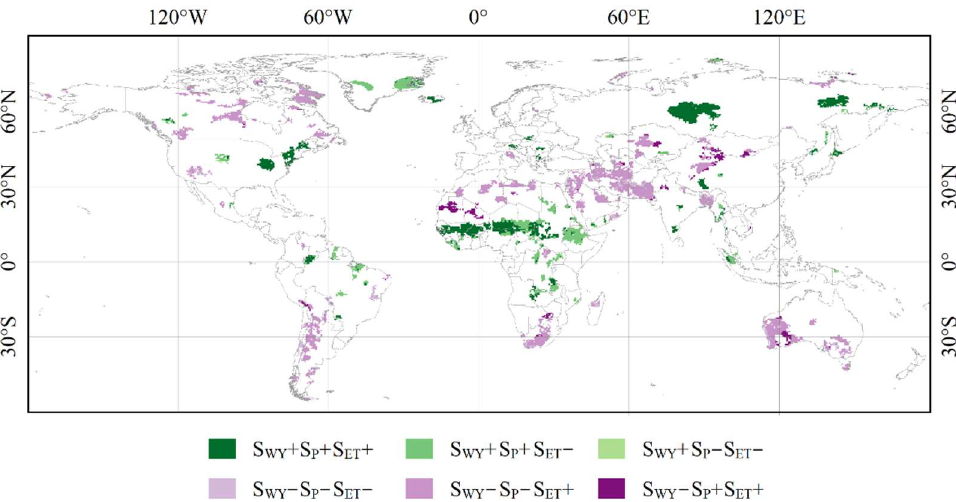
Figure 7. Composite map of the sign of terrestrial water yield (WY), precipitation (P), and evapotran- spiration (ET) trends. Colored areas indicate where WY significantly changed during 1981–2018 after correcting for multiple hypothesis testing (α = 0.05). S WY , S P , and S ET indicate the Theil–Sen’s slope of WY, P, and ET, respectively. The symbols + and − indicate a positive and negative WY (P or ET) trend during the study period, respectively.